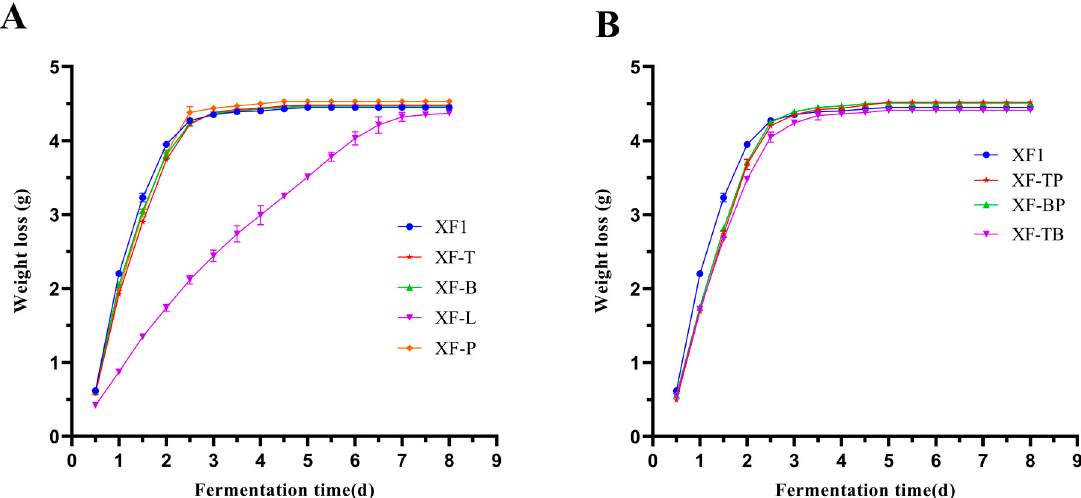
Figure 2. Comparison of fermentation rates of different recombinant strains and the wild-type strain XF1. ( A ) The CO 2 production of single gene-deletion strains and XF1. ( B ) The CO 2 production of double gene-deletion strains and XF1.